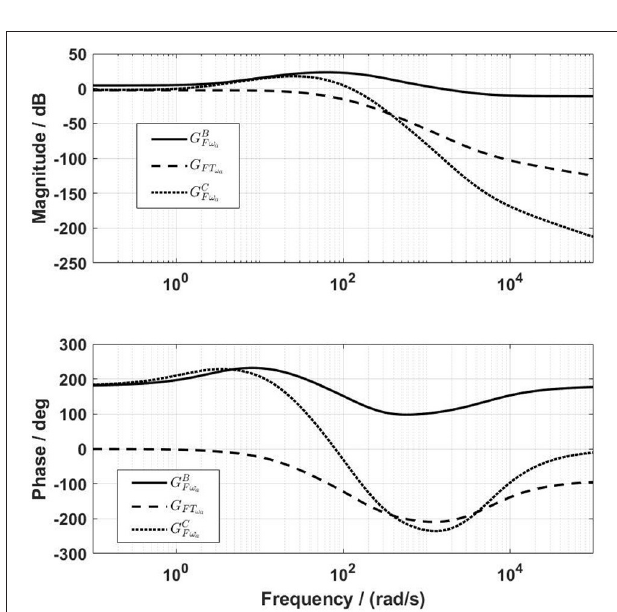
participant walked at 0.1 m/s are presented in Figure 5 . It FIGURE 7 | Frequency characteristics of the compensation channel before ) the inclusion of the velocity-feedforward lead ) and after ( G C F ω ( G FT ω was observed that the model yielded more similar results in a a compensator. The amplitude of G C F ω is close to G B F ω for frequencies up to 40 the dynamic tests than in the static tests. This might be due a a rad/s. to static friction, which was neglected in the Simulink model. similar curves with comparable amplitudes to those of the parameters. After repetitive comparisons between the simulated force F sim and the experimental force F exp , the system parameters F exp during the dynamic tests with the sinusoidal reference were determined ( Table 1 ). The PID-regulated results when the